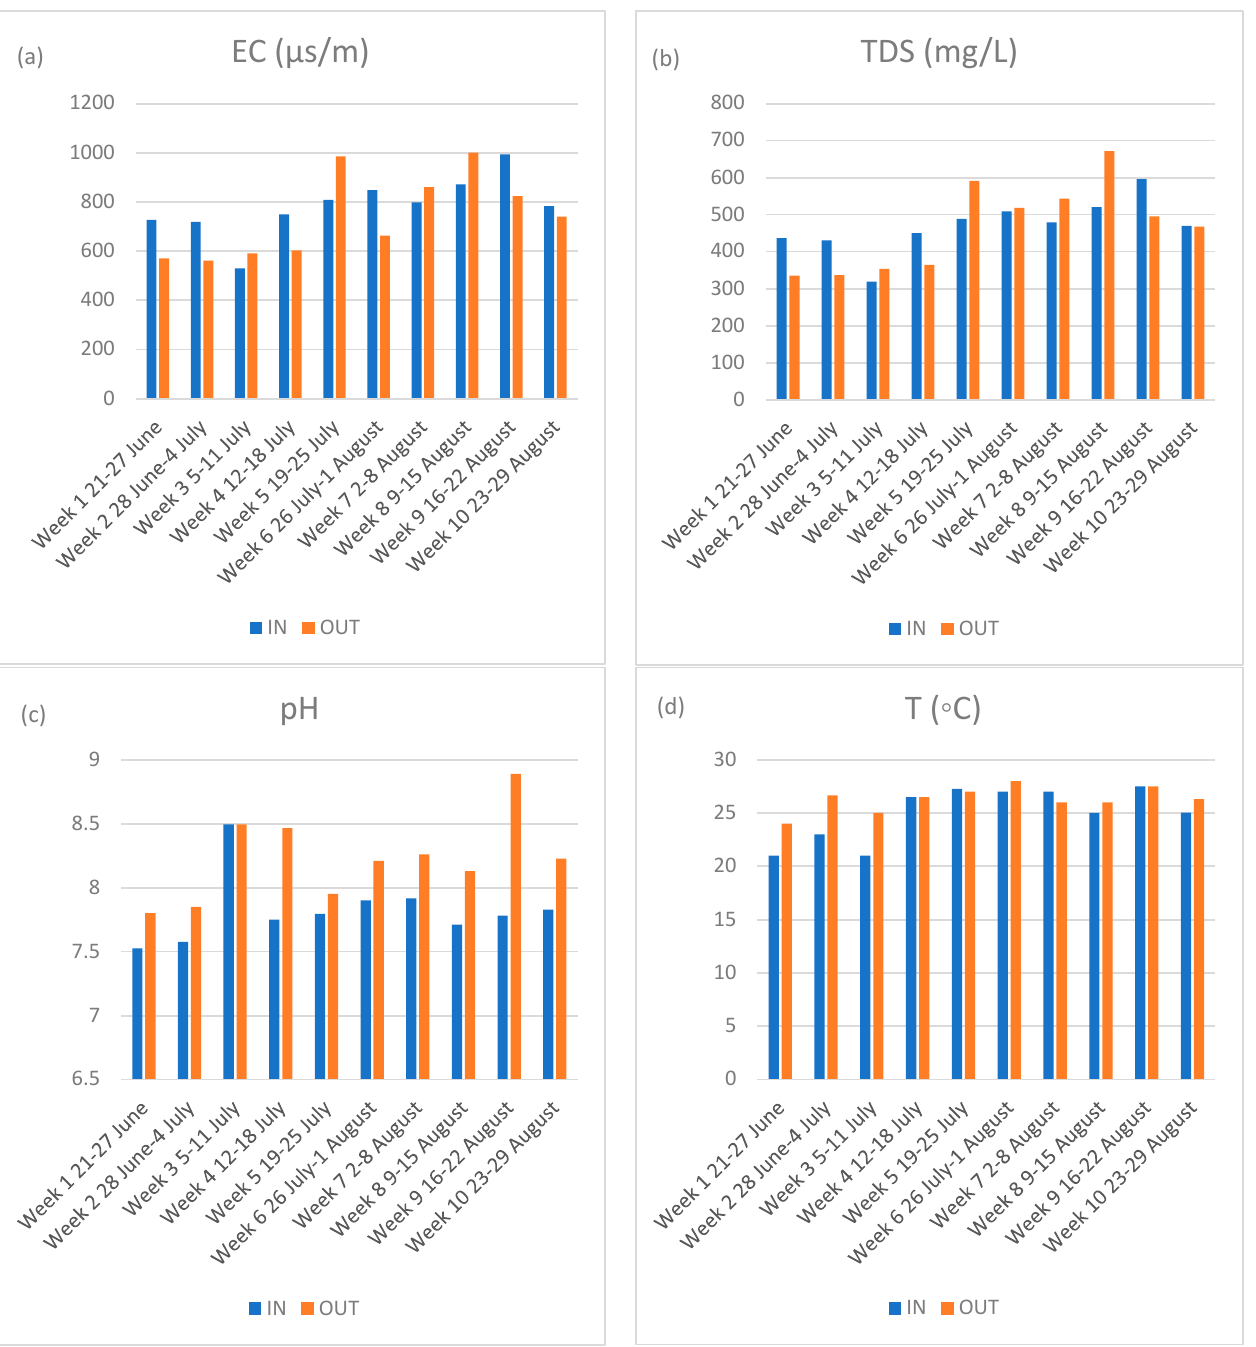
Figure 3. Time course evolution of electrical conductivity ( a ), total dissolved solids ( b ), pH ( c ) water temperature ( d ).